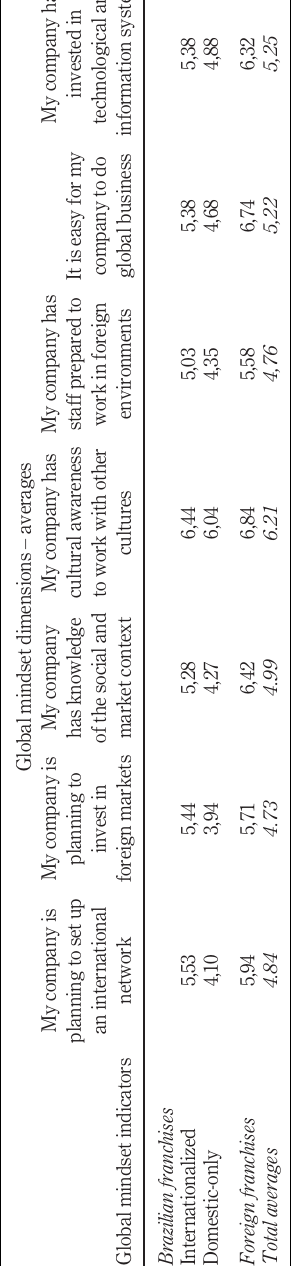
Table II. Averages for each global mindset